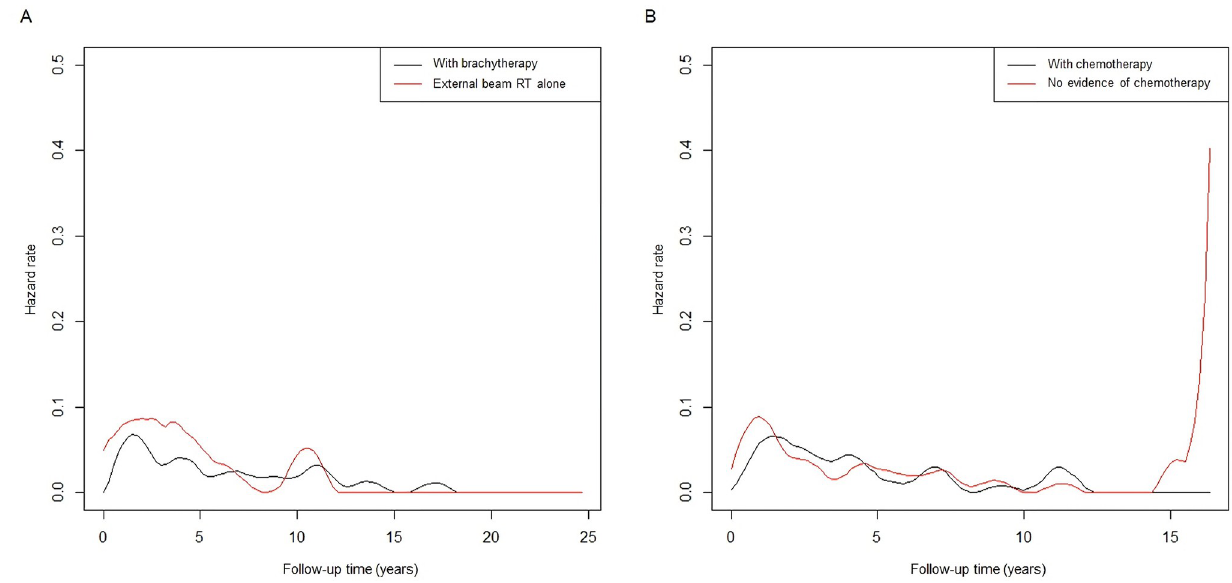
Fig 3. Hazard rate function plots of disease-specific mortality in patients who underwent primary radiotherapy according to use of (A) brachytherapy and (B) chemotherapy. RT, radiotherapy.